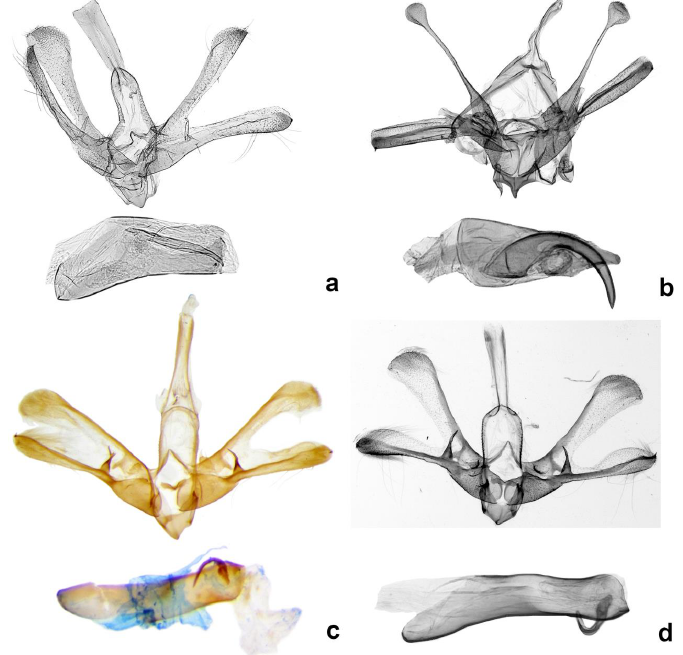
Figure 4. Male genitalia of Nola spp: ( a ) N. costimacula , holotype (MfN, gen. slide No. LGN 1226); ( b ) N. innocua , (NHMUK, gen. slide No. LGN 1902) ( c ) N. galliphaga sp. nov. , paratype (NHMUK, gen. slide No. NHMUK 010317816); ( d ) ditto , paratype (HNHM, gen. slide No. RL 12333). Forests 2022 , 13 , x FOR PEER REVIEW